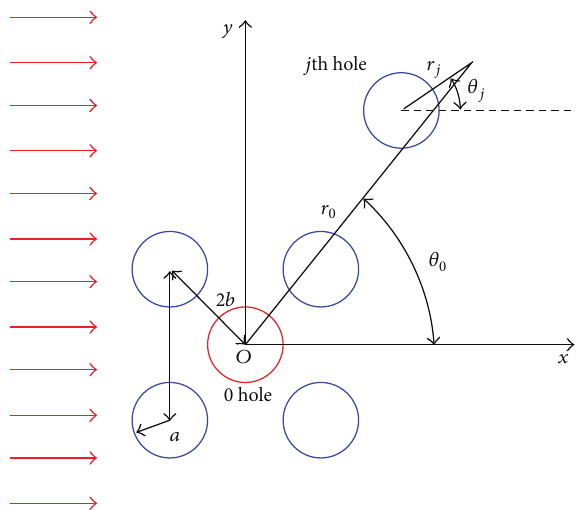
Figure 2: Dimensions and coordinate system for formulating the